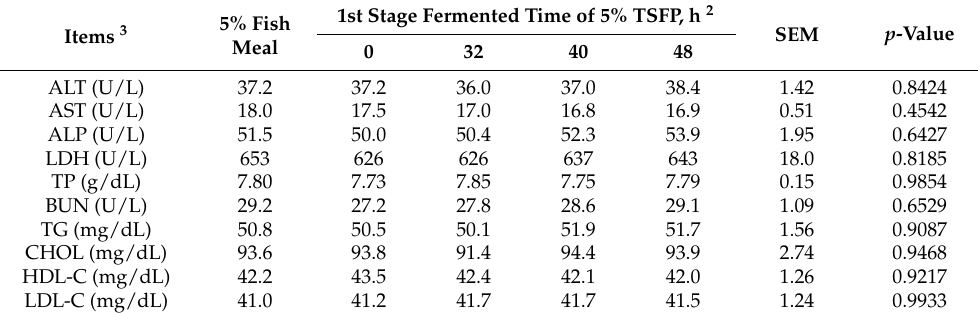
Table 5. Effects of modified TSFP 1 on the blood biochemistry of nursery pigs in trial